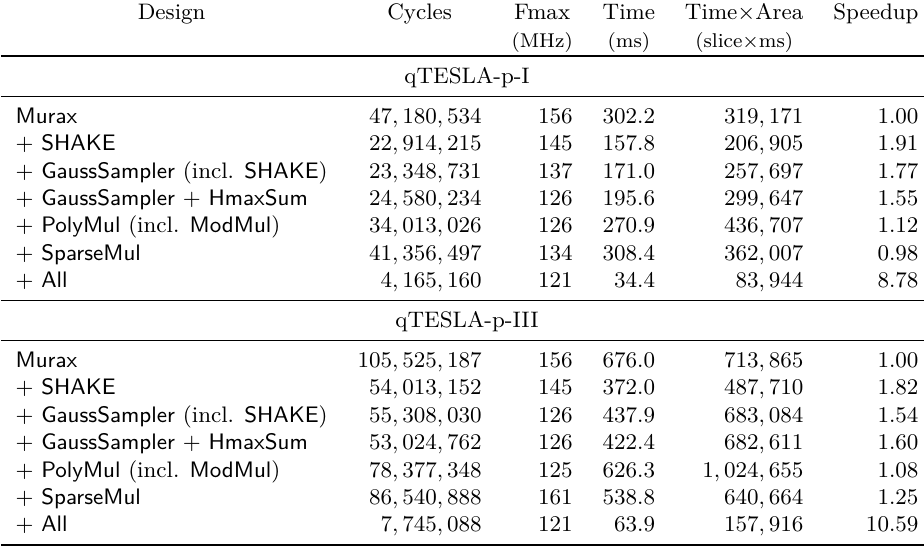
Table 10: Performance of qTESLA signature generation on software and different HW-SW co-designs. All = GaussSampler + HmaxSum + PolyMul + SparseMul . The “Speedup” column is provided in terms of